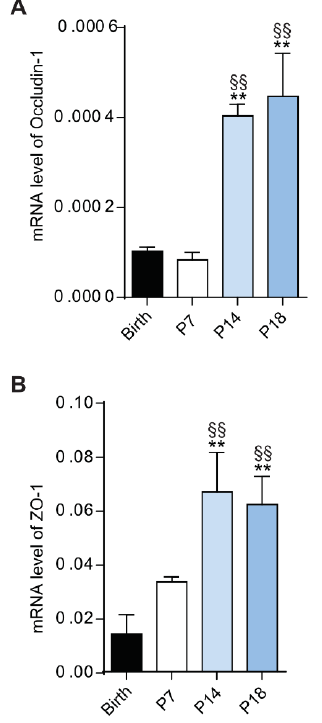
Figure 2. Expression of blood-retina barrier genes during retina rat development. mRNA expression of occludin-1 ( A ) and zonula occludens (ZO-1) ( B ) genes was evaluated by qPCR in rat retinas at birth, P7, P14 and P18. Data is presented as mean ± SEM. One-way ANOVA was used as statistical analysis, followed by Bonferroni’s multiple comparisons test ( n = 6; ** p < 0.01 vs birth, §§ p < 0.01 vs P7).